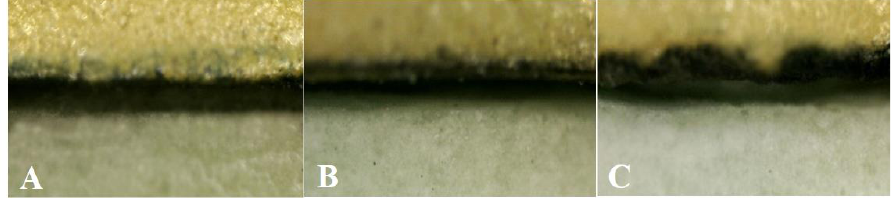
Figure 9. Marginal fit of PFM dental restoration after final glazing procedure at ×300 magnification ( A ) casting, ( B ) milling, ( C ) SLM. ( A ) casting, ( B ) milling, ( C )